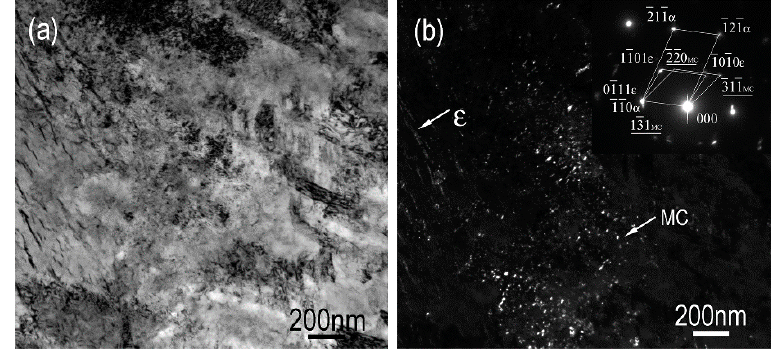
Figure 4. ( a ) BF and ( b ) DF micrographs of carbides at 25 °C, with the corresponding SAED pattern shown in ( b ).